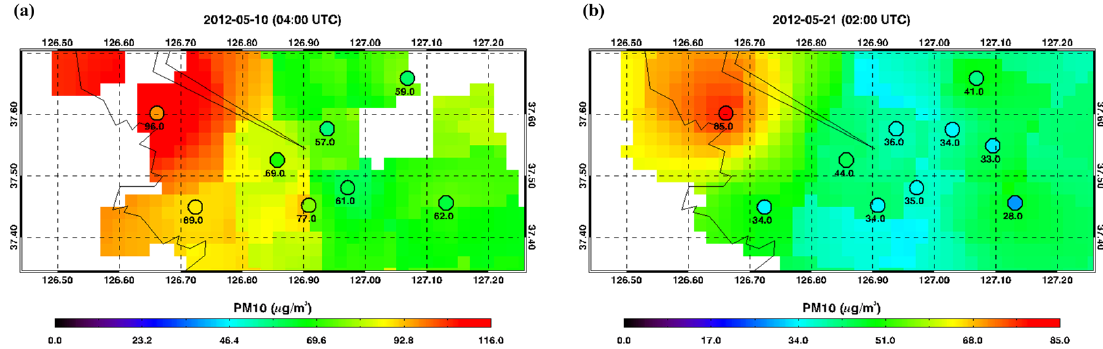
Figure 6. Distribution of hourly surface PM 10 concentrations estimated by model M2 using the MODIS data sets for (a) 04:00UTC on 10 May 2012 and (b) 02:00UTC on 21 May 2012. Circles indicate the observed PM 10 concentrations at PM monitoring